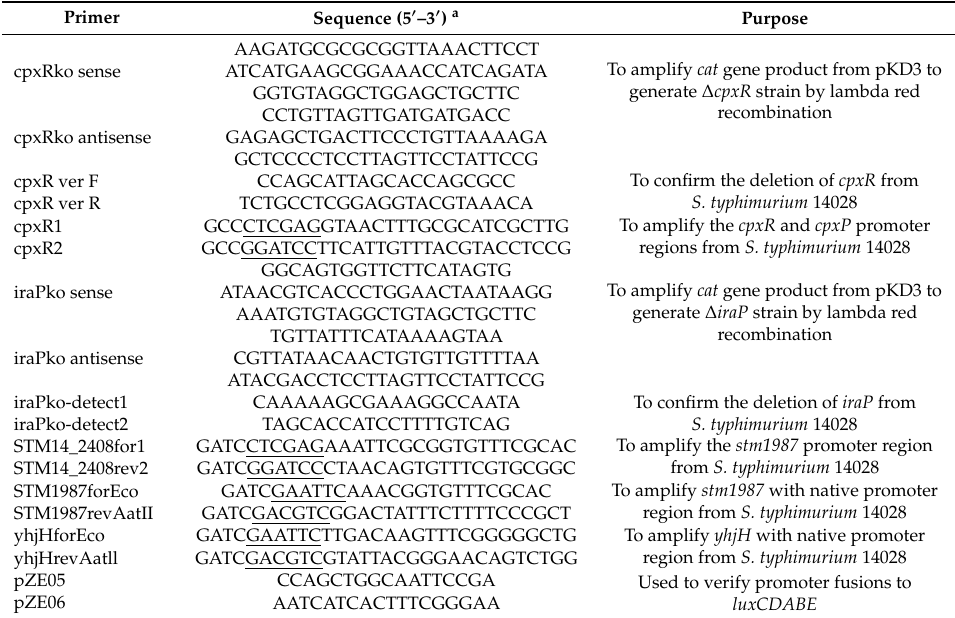
Table 2. Oligonucleotides used in this